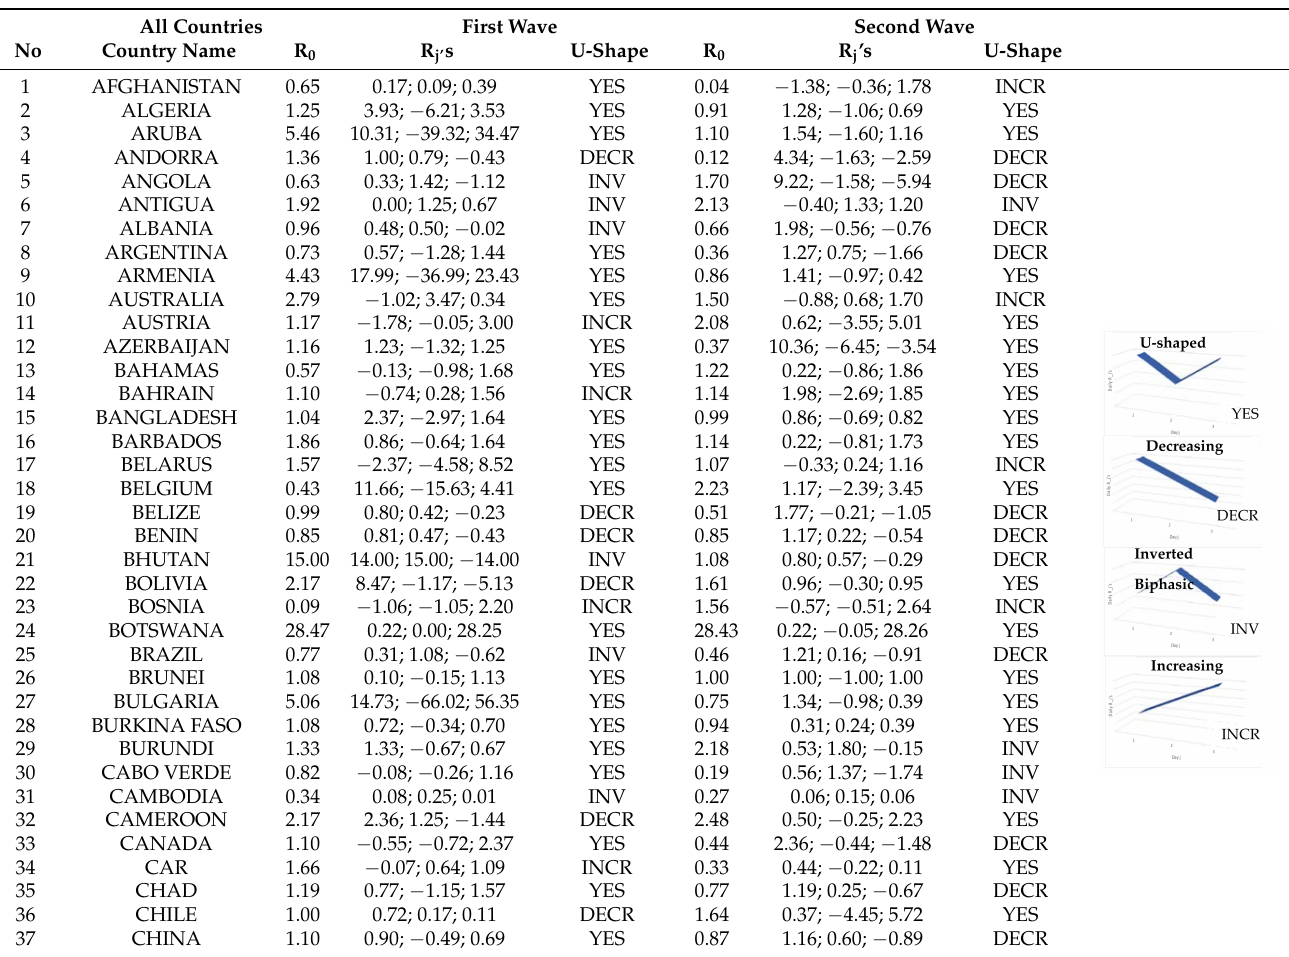
Table A1 is built from new COVID-19 cases at the start of the first and second waves for 194 countries; it shows 42 among these 194 countries having a U-shape evolution of their daily R j ’s twice, for 12.12 ± 6 expected with 0.95 confidence ( p < 10 − 12 ), and 189 times, a U-shape evolution for all countries and waves (397), for 99.3 ± 9 expected with 0.95 confidence ( p < 10 − 24 ). Hence, the U-shape is the most frequent evolution of daily R j ’s, which confirms the comparison with the behavior of seasonal influenza (see Section 2.2). Table A1. Calculation of the daily R j ’s and shape of their distribution for 194 countries and for the two first